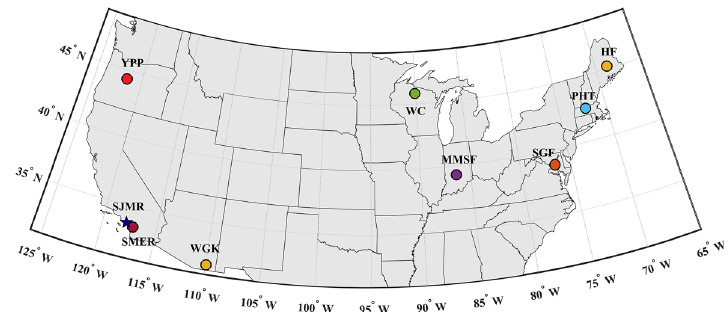
Figure 1. Study sites across the CONUS. Colors denote each study site and names (see Table 1) in which measurements have been observed. Zhang et al. 37 (MMSF) performed two studies at the same location. Varner et al. (2010) and Savage et al. 38 (PHT) gathered data at the same location, but during different time periods. This Figure was created with Matlab version